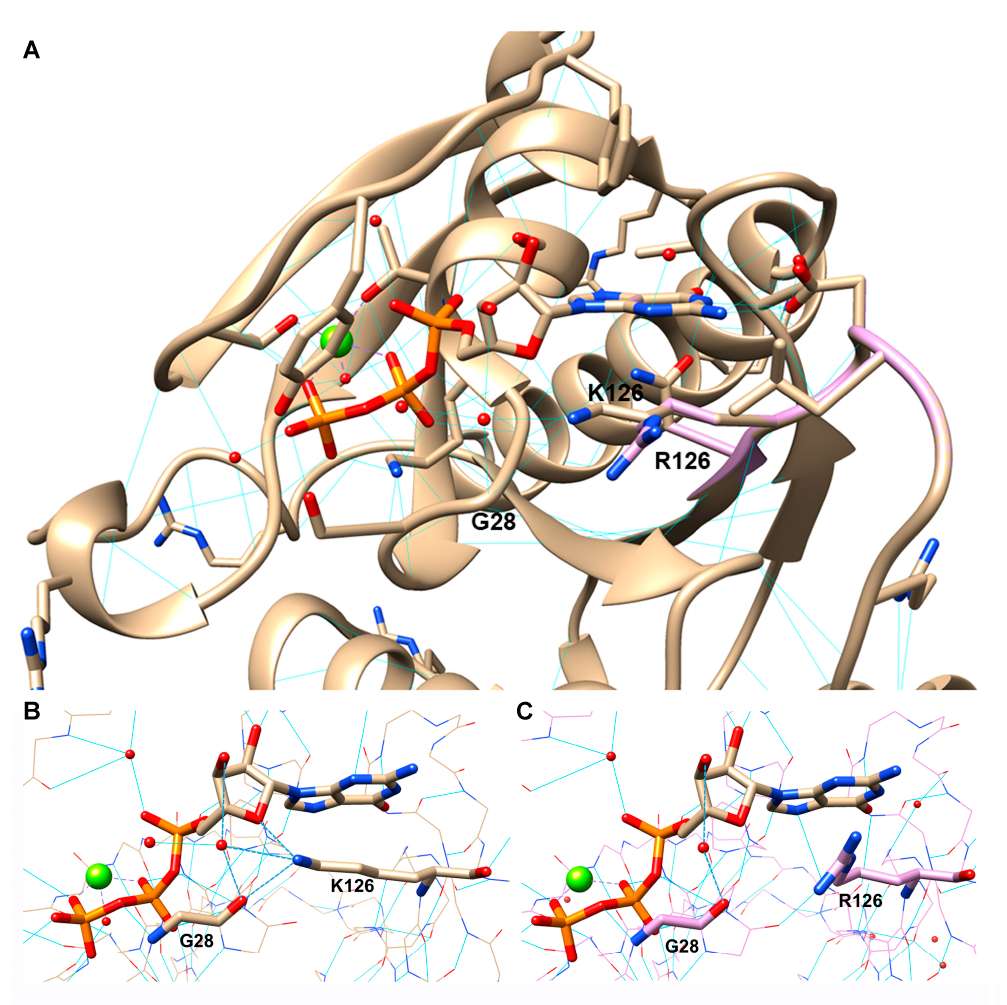
Figure 6. Structural insights into the disease-causing RAB7 K126R mutant. ( A ) Comparison between the wild type (pdb code 1T91) and the virtual model of the mutated protein, colored in light brown and light pink, respectively. The RAB7 K126R mutation is located in the GTPase domain. ( B , C ) The H-bond interactions performed by K126 ( B ) or R126 ( C ), GTP, a conserved water molecule and G28. The protein is colored in light brown ( B ) or light pink ( C ). Bold dashed blue lines highlight the specific H bond net performed by residue 126, GTP, G28, and water. Light blue lines indicate H-bonds. Magnesium ion is represented as a green sphere and water molecules are represented as red spheres.